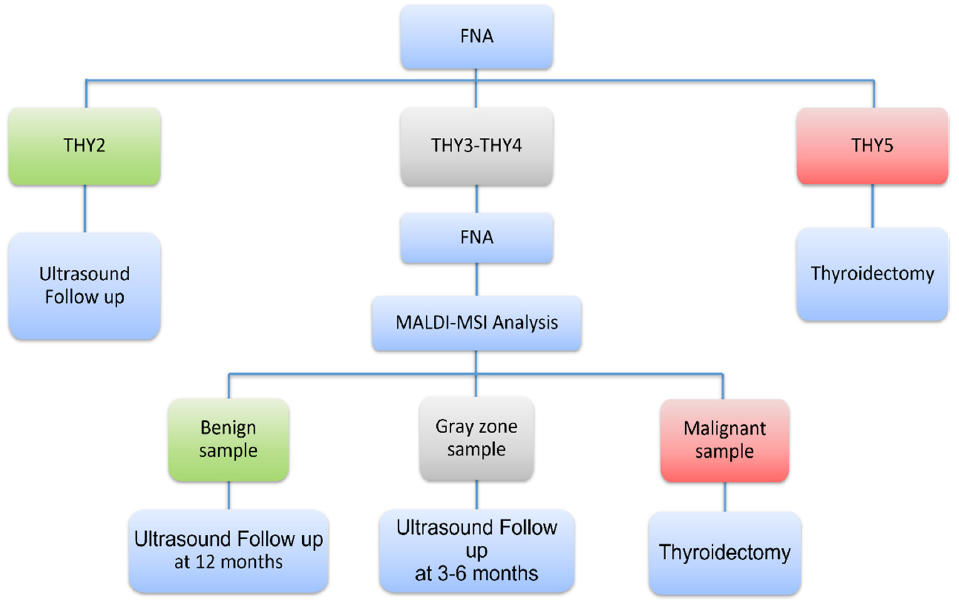
Figure 2. Diagnostic flow ‐ chart combining cytopathology and MALDI ‐ MSI proteomic analysis.